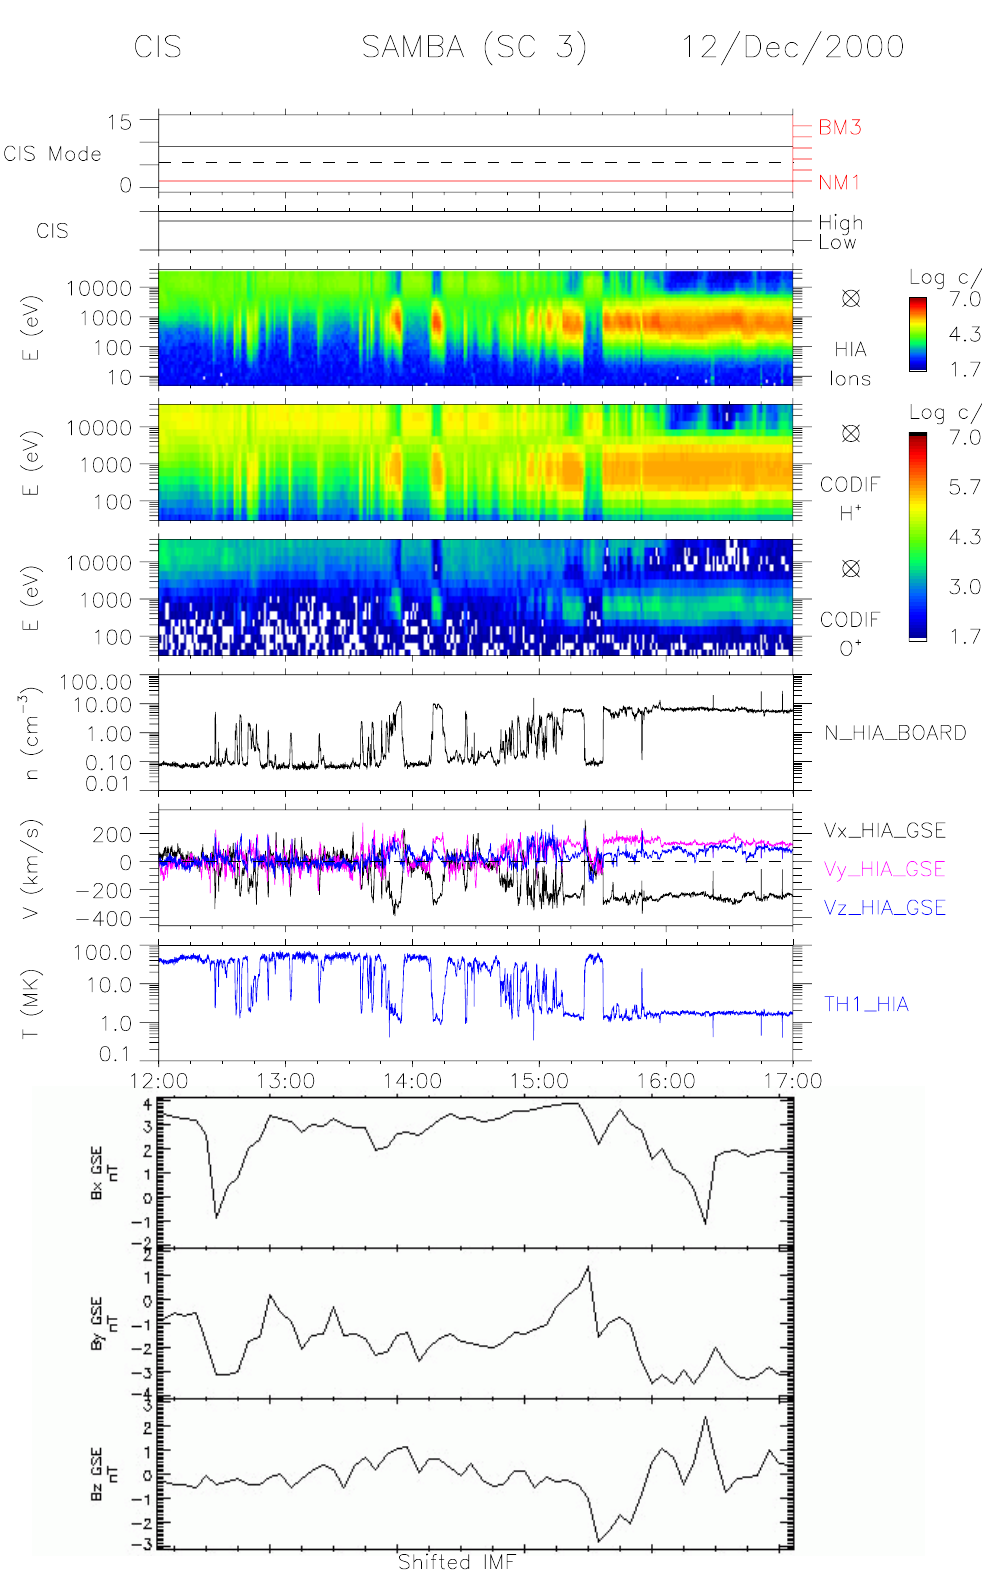
Fig. 29. 12 December 2000 magnetopause crossings between 12:00 and 17:00UT as seen by spacecraft 3; from top to bottom: instrument modes, energy-time spectrograms of HIA ions, CODIF H + , and CODIF O + , HIA density, HIA velocity, and shifted IMF (from ACE, courtesy of N. Ness). The 1keV CODIF O + in the magnetosheath are instrument artifacts due to the contamination from high H + fluxes. The 10keV O + are true O +